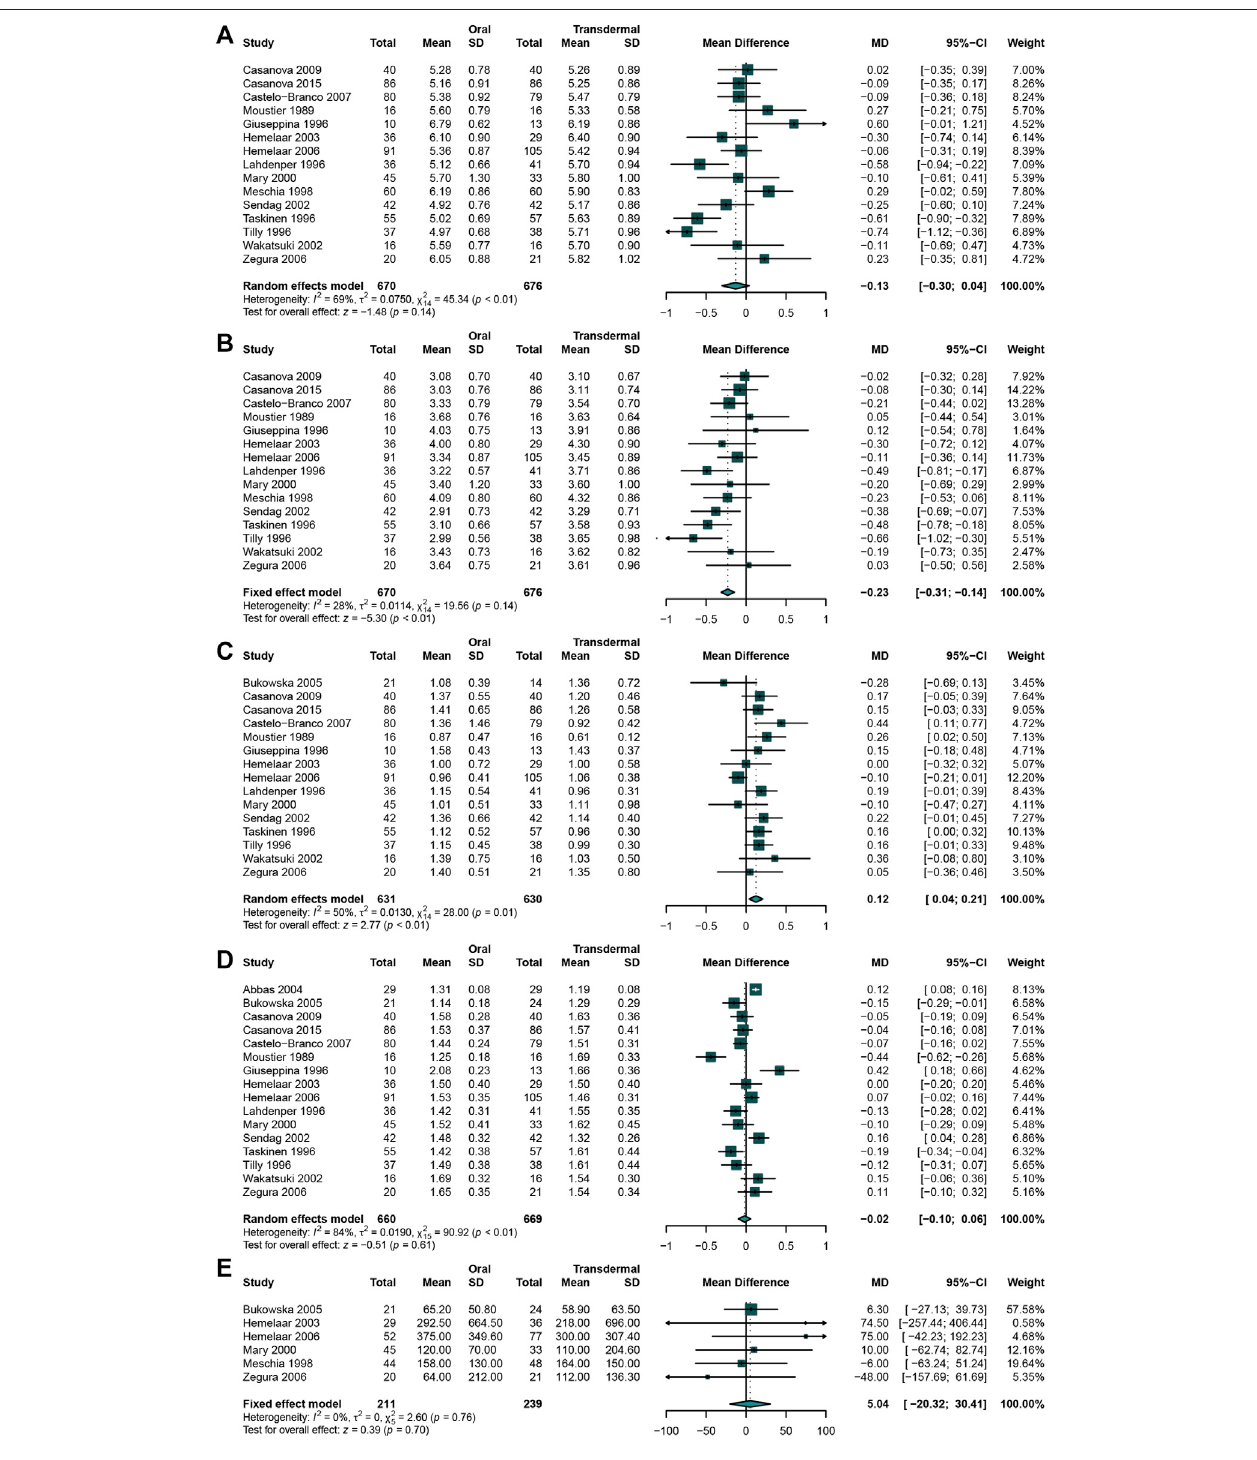
FIGURE 5 | Comparing oral estrogen with transdermal estrogen Oral MHT signi fi cantly decreased LDL-C concentration and increased TG concentration comparedwiththatintransdermalMHTgroup. (A) TCconcentration; (B) LDL-Cconcentration; (C) TGconcentration; (D) HDL-Cconcentration; (E) Lp(a)concentration.